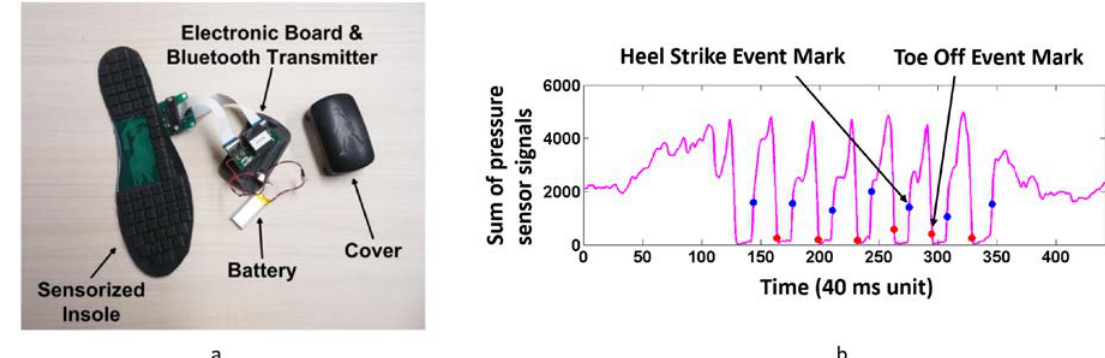
Figure 1. ( a ) Instrumented footwear for gait monitoring presented by and Crea et al. [5] ; ( b ) marking of heel strike and toe off time instances from the pressure sensor signals.